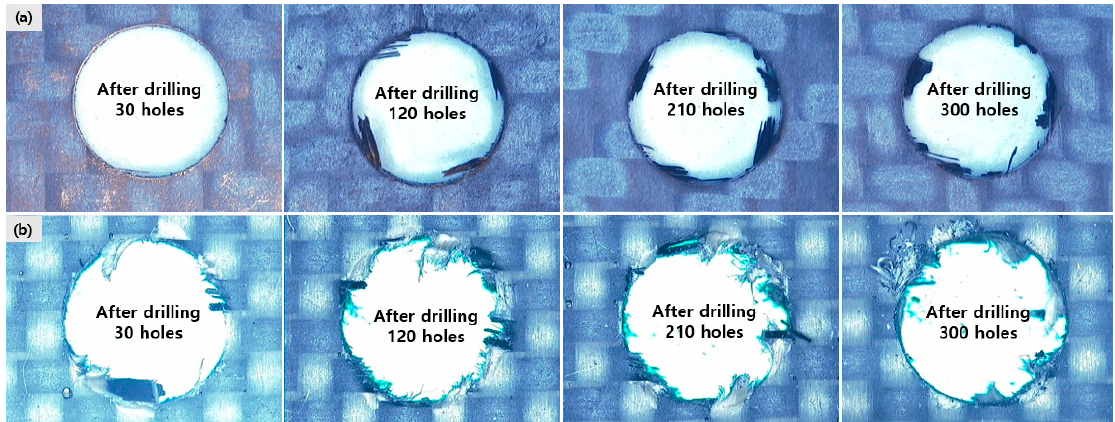
Figure 7. Burr formation in drilling of ( a ) CFRP and ( b ) C-AFRP.